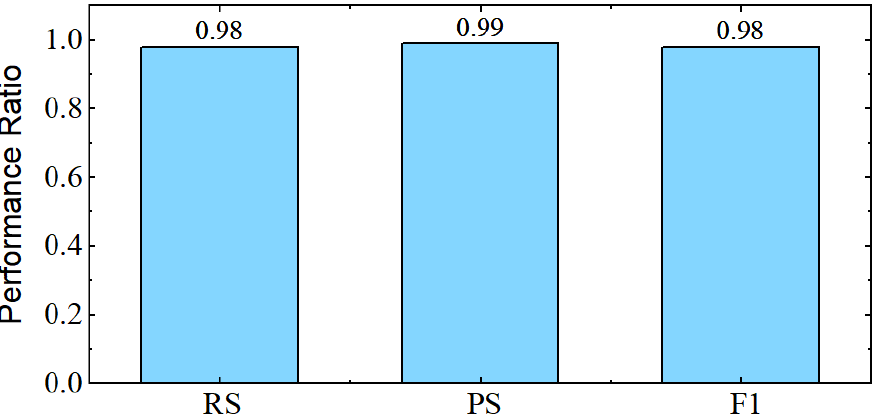
Figure 17. Recal, precision and F1 score of our final bagged ensemble learning based